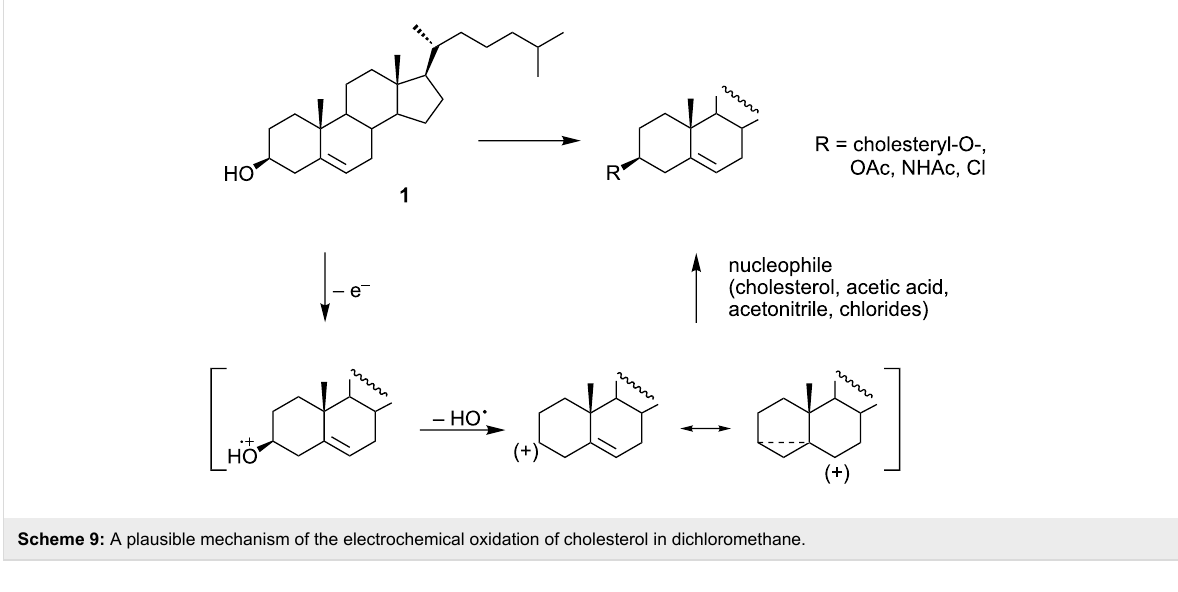
Scheme 10: The electrochemical formation of glycosides and glycoconjugates.